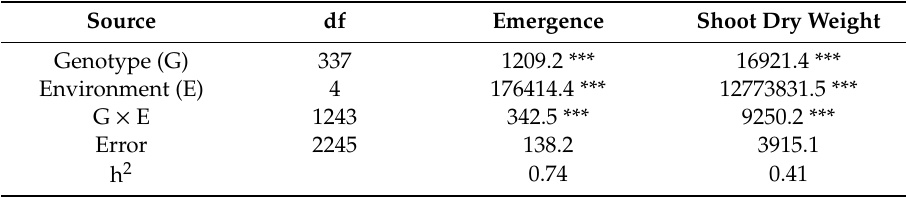
Table 6. Variances (mean squares) and heritability for emergence and SDW over all five environments. G, E, G × E, and error-variance were computed using a general linear model in which genotypes and environments were considered as fixed and replicates as random e ff ects. For heritability estimation, a fully random model was applied (see Materials and Methods).